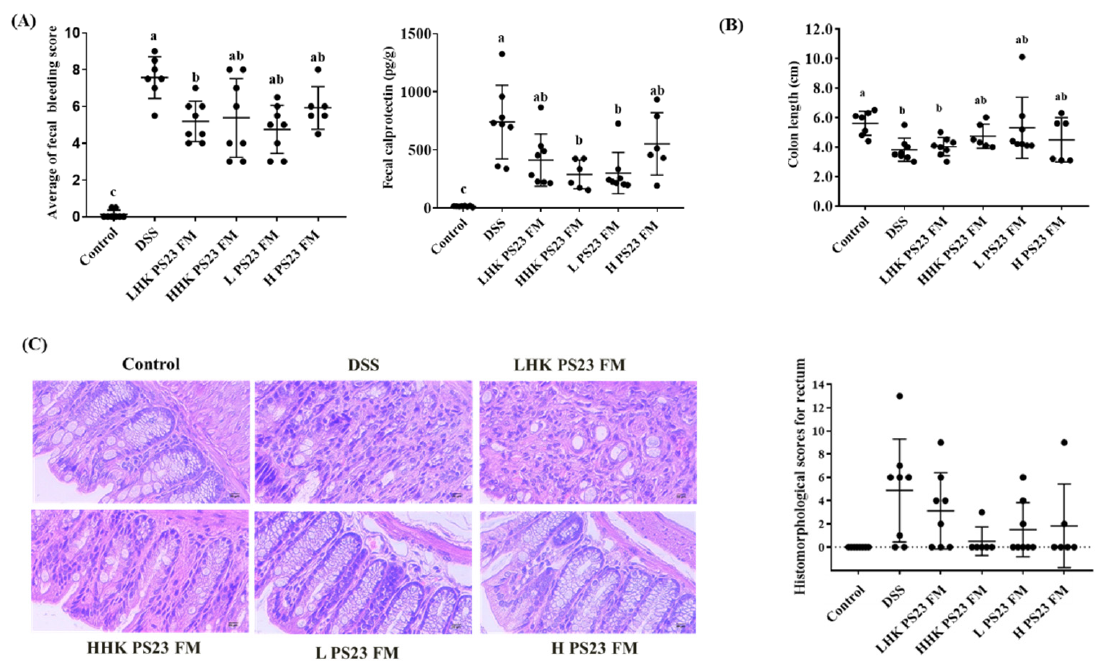
Figure 4. Effect of PS23-fermented milk on ( A ) fecal bleeding score and fecal calprotectin, ( B ) the lengths of colons, and ( C ) rectum histologic evaluation in a DSS-induced colitis mouse model. Data are expressed as means ± SD ( n = 6–8). Statistical analysis was performed using analysis of variance with the Tukey test. Different letters in ( A , B ) indicate a significant difference ( p < 0.05). DSS: negative control; LPS23 FM: low-dose L. paracasei PS23 with yogurt culture fermented milk (10 7 CFU/mouse); LHK PS23 FM: heat-killed LPS23 FM; HPS23 FM: high-dose L. paracasei PS23 with yogurt culture fermented milk (10 8 CFU/mouse); HHK PS23 FM: heat-killed HPS23 FM. SD: standard deviation.